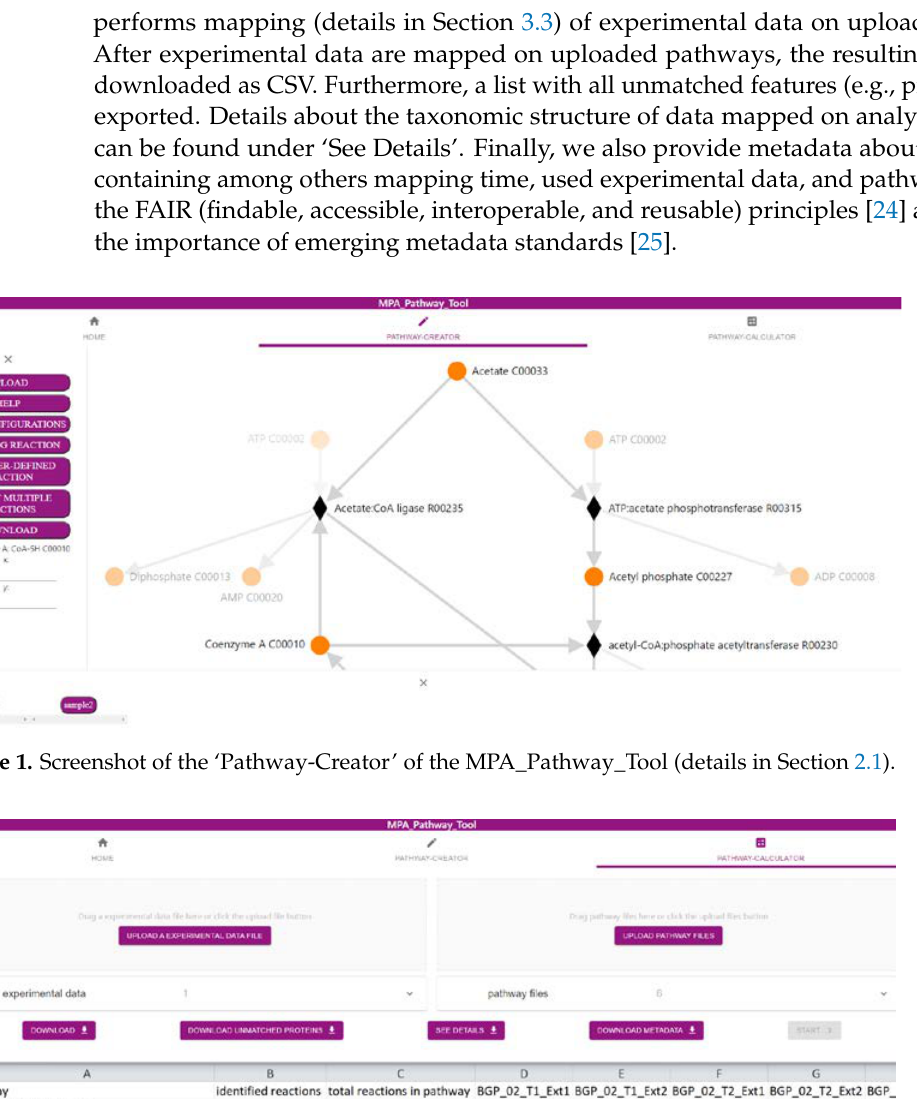
Figure 2. Screenshot of the ‘Pathway-Calculator’ of the MPA_Pathway_Tool (details in Section 2.2). Finally, we tested the performance of the ‘Pathway-Calculator’ by uploading experi- mental data with different file sizes (10,000 proteins, 100,000 proteins, and 1,000,000 proteins with 44 samples per test) and a different number of pathways on a local desktop computer (AMD Ryzen 5 3600, 16 GB DDR4 RAM 3000 MHz, Chrome Browser version 89.0.4389.90). We utilized 1, 10, and 100 copies of the user-defined Wood–Ljungdahl pathway used in Heyer et al. [8] (Biogas plant (BGP)-Wood–Ljungdahl pathway) for the performance test. Each test with 10,000 and 100,000 proteins finished within 1 min, indicating a good perfor- mance for most files. Tests with 1,000,000 proteins took longer (up to 12 min) caused by higher upload times and high requirements on memory and on CPU performance (Table